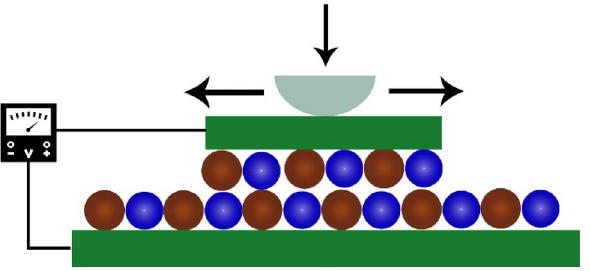
Figure 7. Schematic diagram of an InN-based compression-sliding motion nanogenerator model. The probe and electrodes are denoted by light cyan and green colors,